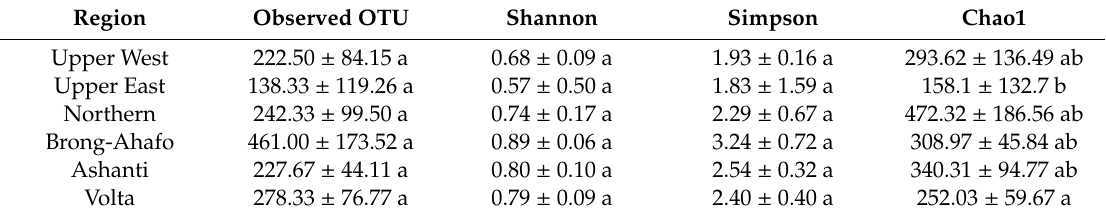
Table 2. AMF diversity and species richness. Alpha-diversity metrics of samples based on rarefied operational taxonomic units (OTUs) in analyzed rice roots sampled from different regions across Ghana.